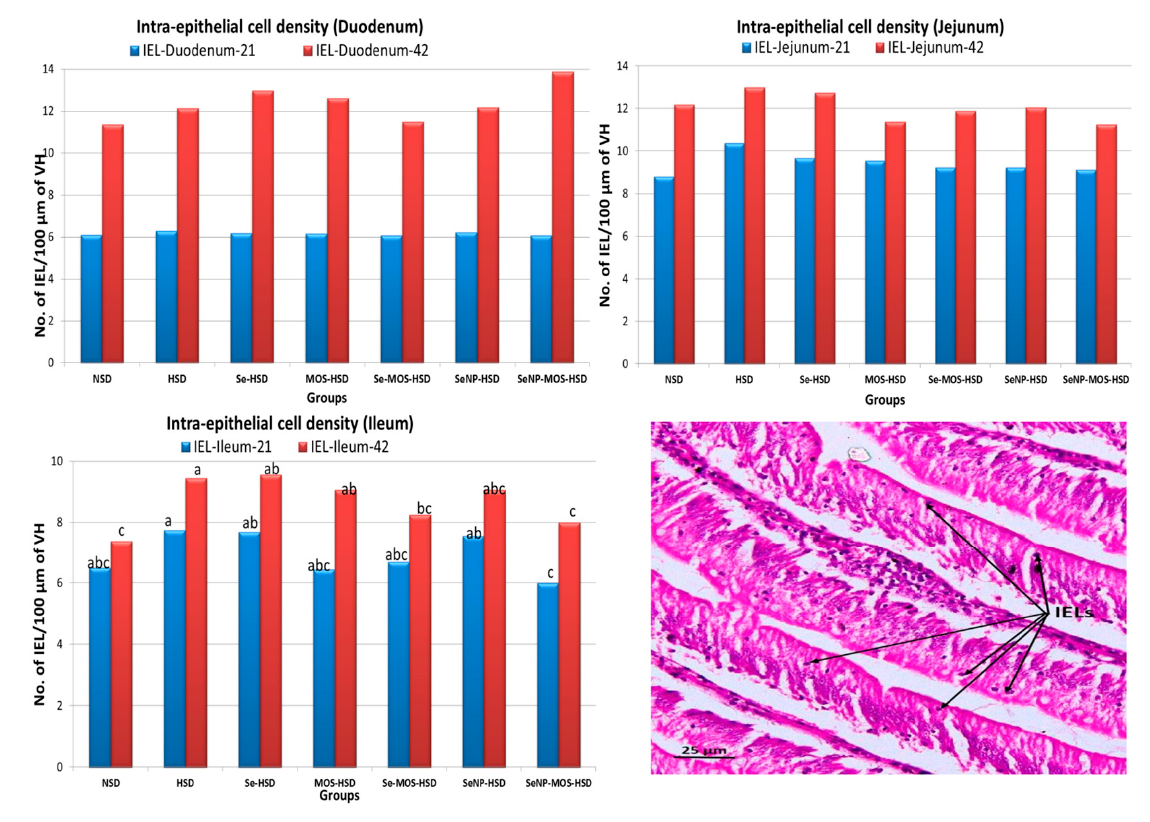
Figure 1. Graphs comparing the intra-epithelial lymphocyte (IEL) density in the segments of small intestine on day 21 and day 42 among groups. The bar height shows the number of intra-epithelial lymphocytes (IEL) per 100 µm of the middle portion of villus height in the two-dimensional image. These values represent the means of eight replicates per group (16 birds per group). NSD: normal stocking density, HSD: high stocking density, Se: selenium selenite, MOS: mannan oligosaccharide, SeNP: selenium nanoparticles. PCNA: proliferating cell nuclear antigen bar of the same color with different letters differs significantly between groups. The micrograph in the right lower corner shows arrowed IELs. (H–E stained, 40×).